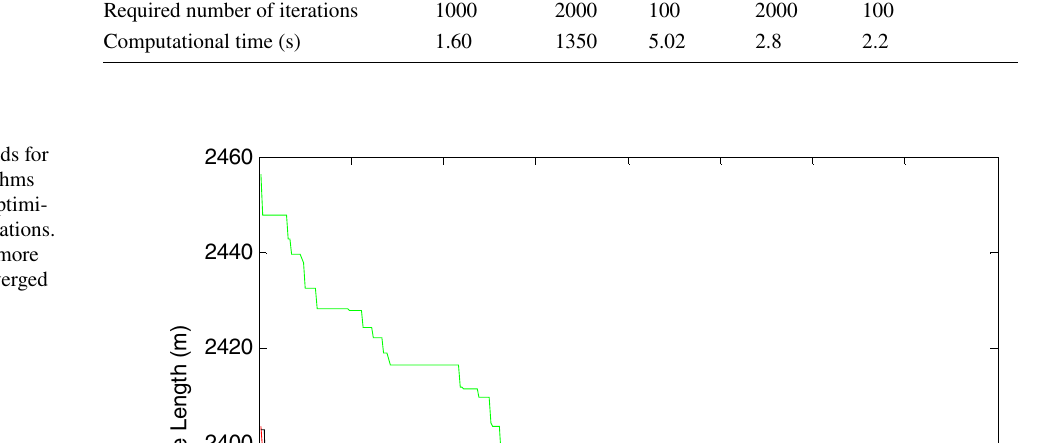
Table 7 Comparative results of tuned metaheuristic algorithms applied to the wellbore optimization Case 2